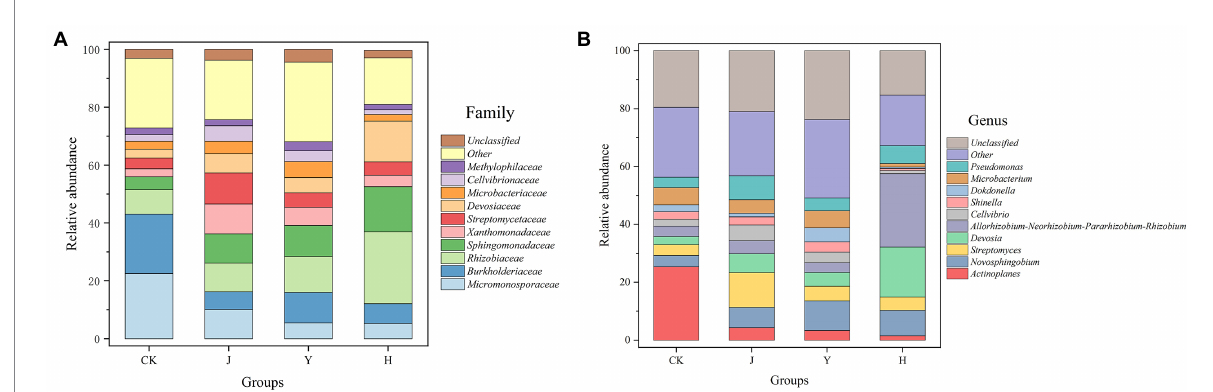
FIGURE 3 (A,B) Comparison of microbial populations at family and genus level in root. CK represents soybean-potted rhizosphere soil inoculated with 50 mL saline solution. J, Y, and H represent soybean-potted rhizosphere soil inoculated with 50 mL Pseudomonas chlororaphis H1 inoculant, 50 mL